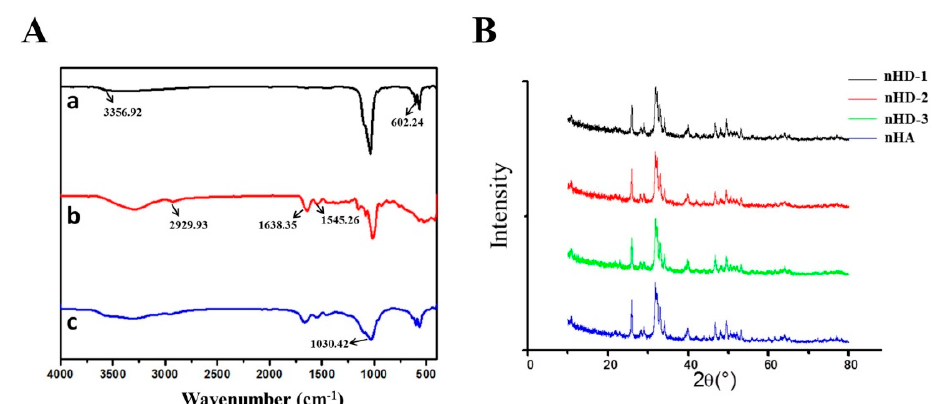
Figure 3. The characterization of nHD scaffolds. ( A ) FT-IR spectra of nHA ( a ), HLC ( b ) and nHD scaffolds ( c ). ( B ) XRD patterns for nHD-1, nHD-2 and nHD-3 scaffolds cross-linked by various concentrations of DEO, 4%, 6% and 8%, respectively.